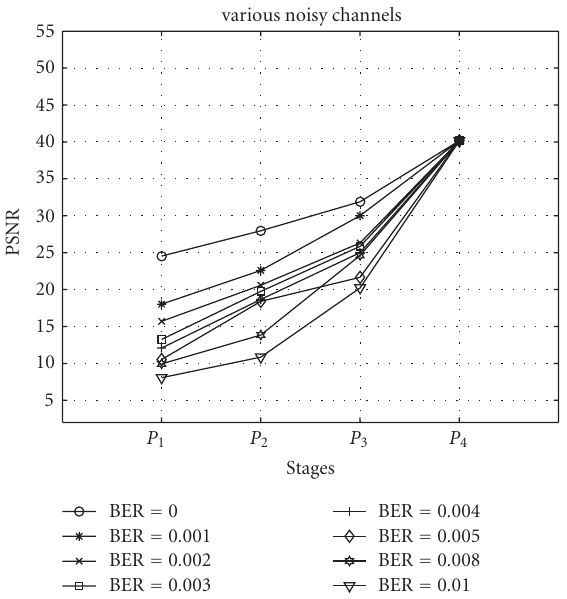
Figure 8: PSNR for successive transmission of four stages at di ff erent BERs under various noise-level conditions.